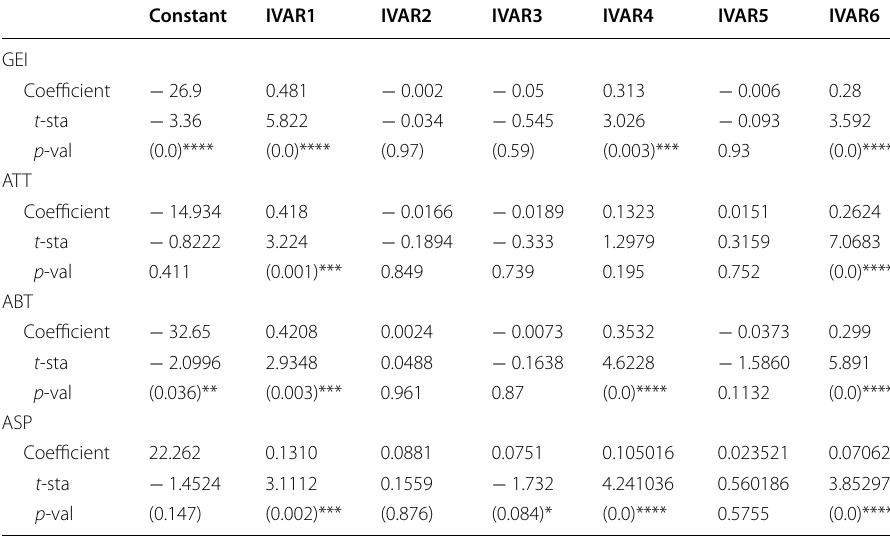
Table 5 Correlated panel corrected standard error regression